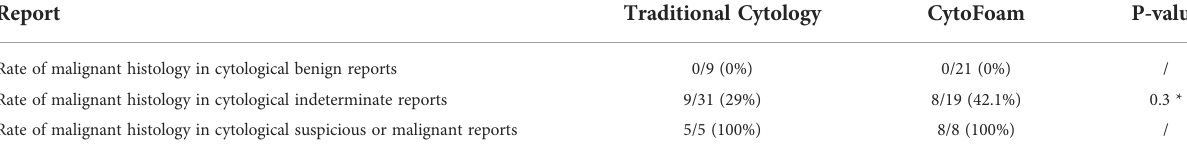
TABLE 4 Traditional cytology vs cytofoam. Rate of inadequate and indeterminate reports and rate of malignant histology in indeterminate, suspicious or malignant reports.